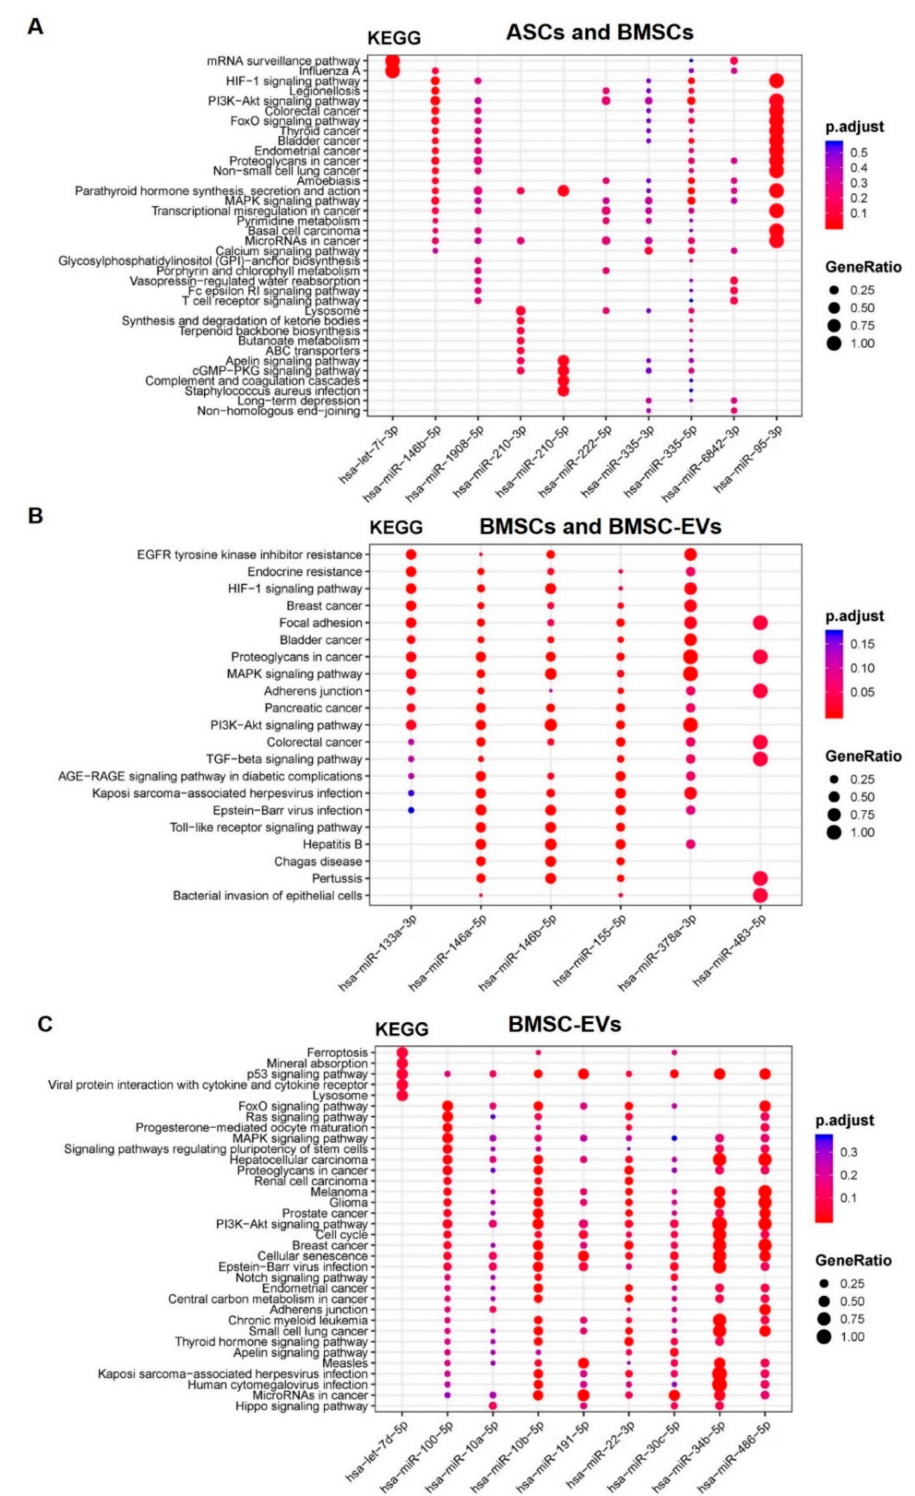
Figure 4. Functional enrichment analysis for target genes of di ff erentially expressed miRNAs in osteoblastogenesis. ( A ) miRNAs identified in both ASCs and BMSCs. ( B ) miRNAs identified in both BMSCs and BMSC-EVs. ( C ) miRNAs identified only in BMSC-EVs. The Y -axis shows the annotation categories (e.g., KEGG pathways) and the X -axis shows the miRNAs. The color of the dots represents the adjusted p values (FDR) and the size of the dots represents gene ratio (the number of miRNA targets enriched in each category over the number of total genes associated to that